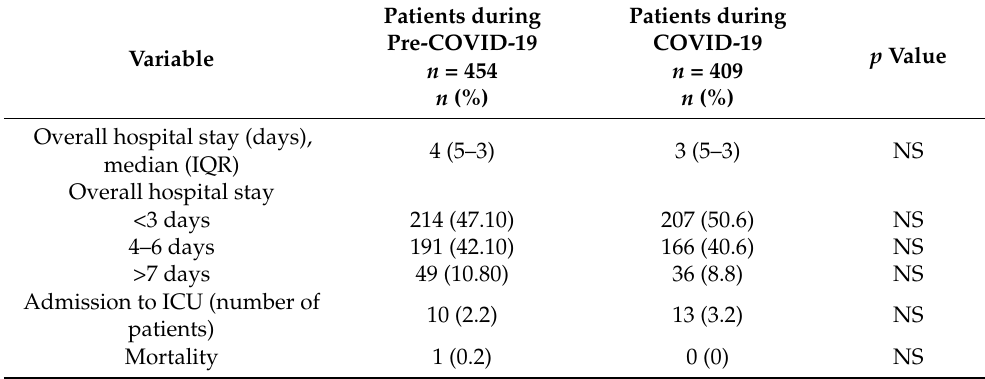
Table 4. Hospitalization and short follow-up outcomes.